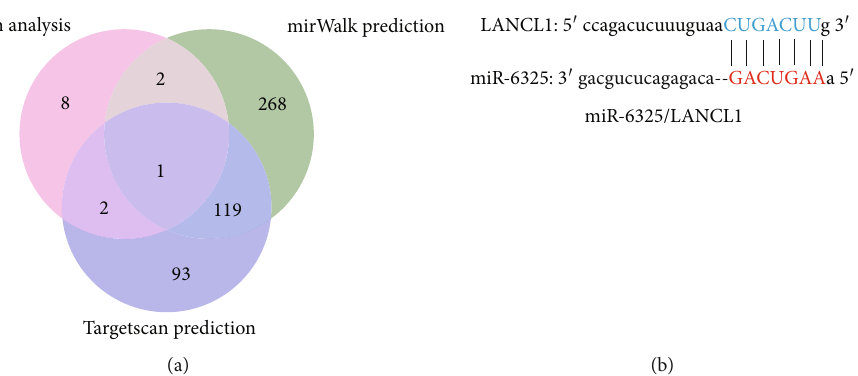
Figure 5: Results of correlation analysis and online database prediction: (a) Venn diagram of miRNA prediction; (b) the binding site of miR-6325/LANCL1